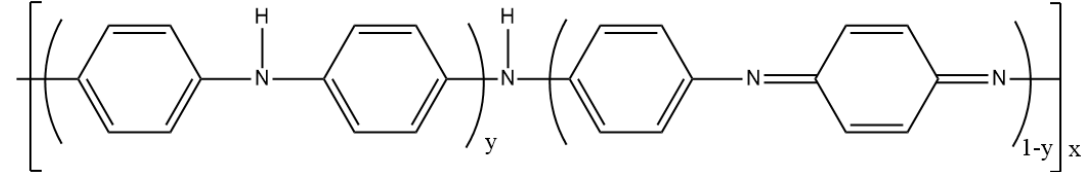
Figure 1. General formula of polyaniline.